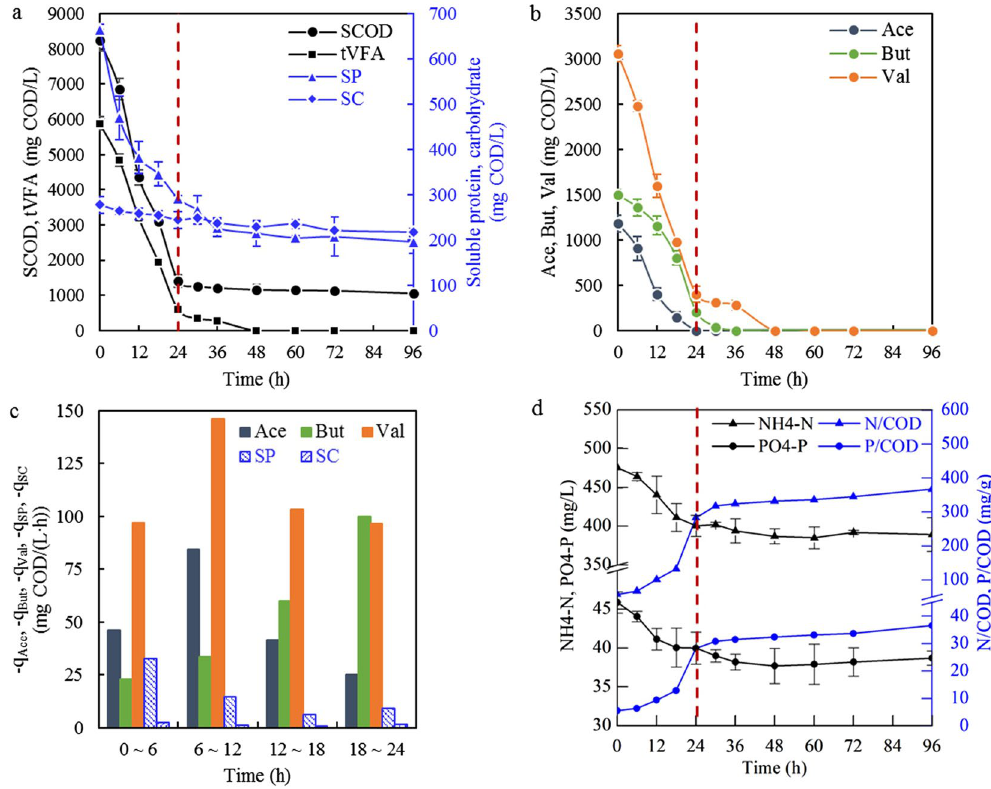
Figure 1. Profiles of SCOD, total VFAs, soluble proteins and carbohydrates ( a ), main VFAs ( b ), their uptake rates ( c ), and nutrients utilization ( d ) during one cycle in the SBR operated under stability. Red dashed lines mark the end of feast phase. The uptake rate represents the average for the marked period. ‘tVFA’: total VFAs, ‘Ace’: acetate, ‘But’: butyrate, ‘Val’: valerate, ‘SP’: soluble proteins, ‘SC’: soluble carbohydrates. (bars = S.D., n =